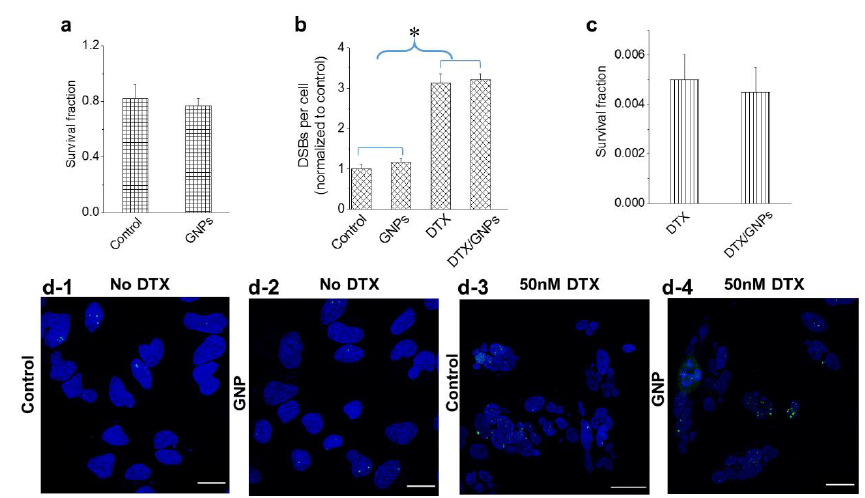
Figure 5. Action of DTX in the presence of GNPs. ( a–b ) The biocompatibility of GNPs was verified by measuring the cell survival fraction and DNA damage, respectively. ( b–c ) The action of the drug in the presence of GNPs was verified by measuring the DNA damage and cell survival fraction, respectively. ( d ) Mapping of DNA double strand breaks (DSBs) in control cells and cell treated with 50 nM DTX. DNA DSBs and nuclei are marked in green and blue, respectively. Scale bar is 20 µm. Error bars are standard deviations from 3 replicate measurements. *Represents a statistically significant difference (Welch’s unequal variance t-test, p < 0.05).